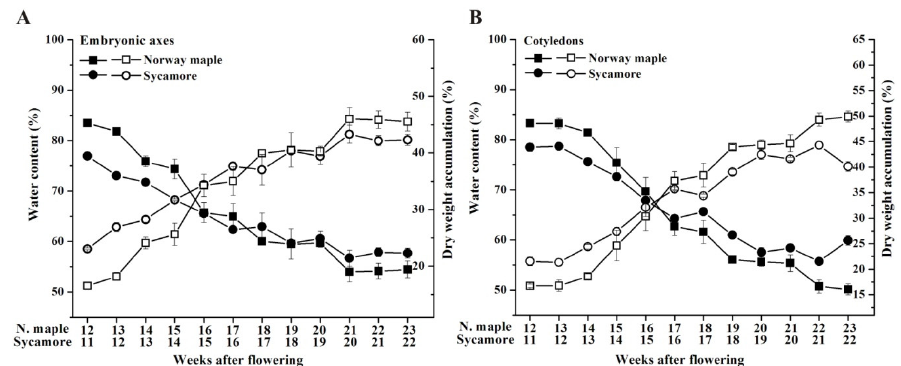
Figure 1. Changes in water content (solid symbol) and dry mass accumulation (open symbol) in the embryonic axes ( A ) and cotyledons ( B ) of developing seeds of Norway maple (squares) and sycamore (circles) collected during the 11th–23rd weeks after flowering. Data are the means of three independent replicates ± the standard deviation. Antioxidants 2020 , 9 , x FOR PEER REVIEW